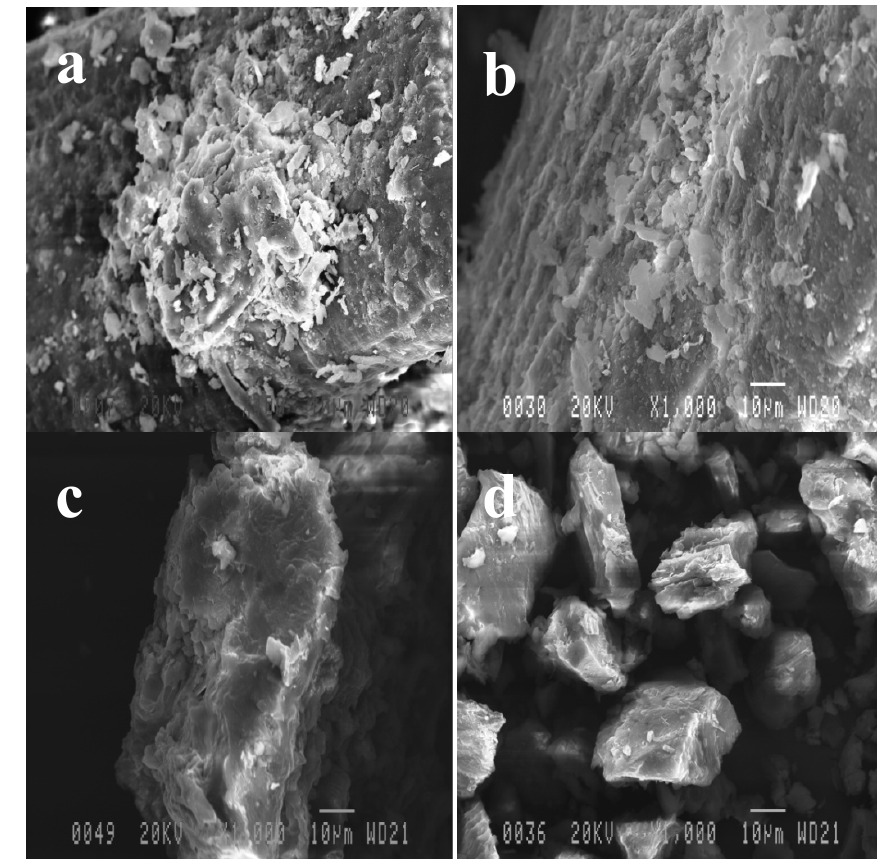
Figure 5. Morphological changes of OPEFB surface before and after pretreatment. All samples were size-reduced using ball milling before hydrolysis and fermentation. ( a )